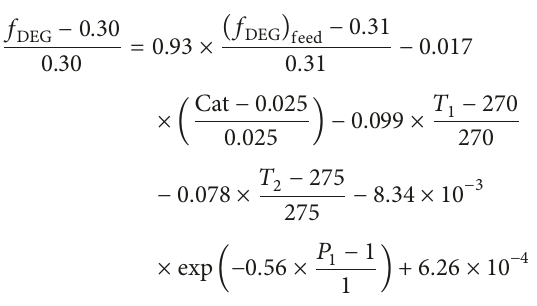
content. An appropriate range of DEG content in PET is allowed to meet the demand for different products. The weight analysis of 𝑓 DEG variation could be listed as follows: